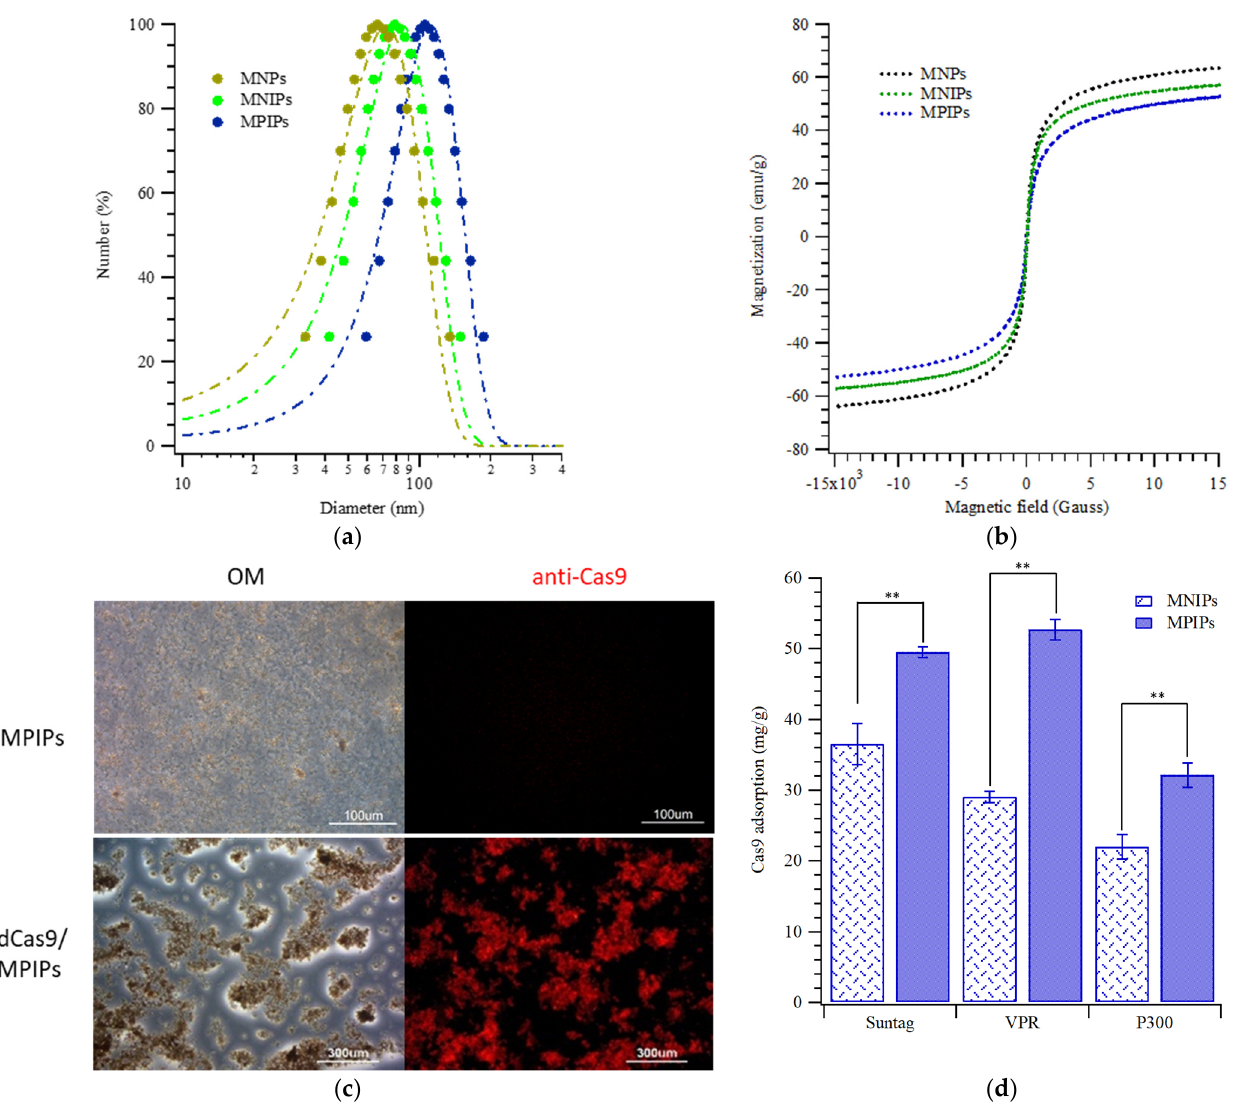
Figure 1. ( a ) Size distribution of the magnetic nanoparticles (MNPs), magnetic non-imprinted chitosan nanoparticles (MNIPs), and peptide-imprinted chitosan nanoparticles (MPIPs). ( b ) Magnetization curves of MNPs, MNIPs, and MPIPs after template removal. ( c ) Immunostaining images of MPIPs without and with adsorption of dCas9a proteins. ( d ) Adsorption capacities of MPIPs with the same concentration of dCas9a proteins. All experiments were carried out in triplicate, and data are expressed as means ± standard deviation. Standard deviation is based on at least three measurements, and **: p <